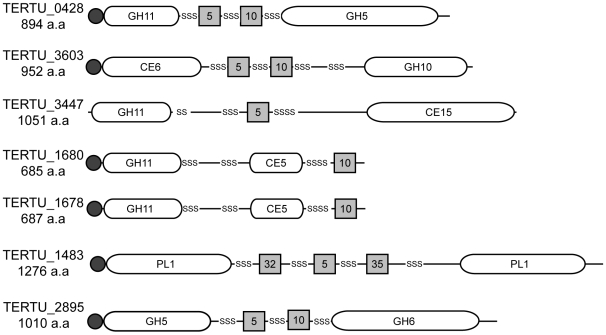
Multicatalytic carbohydrate-active enzymes.The genome of T. turnerae encodes seven multicatalytic enzymes (enzymes containing multiple catalytic domains with distinct predicted substrate specificities). Domain architecture is depicted in schematic form. Key: glycoside hydrolases (GH), carbohydrate esterases (CE), polysaccharide lyases (PL), catalytic domains (white rounded rectangles), carbohydrate binding modules (grey squares), secretion signals (dark circles), and polyserine linker regions (“SS”). Numbers specify domain families (http://afmb.cnrs-mrs.fr/CAZY/).